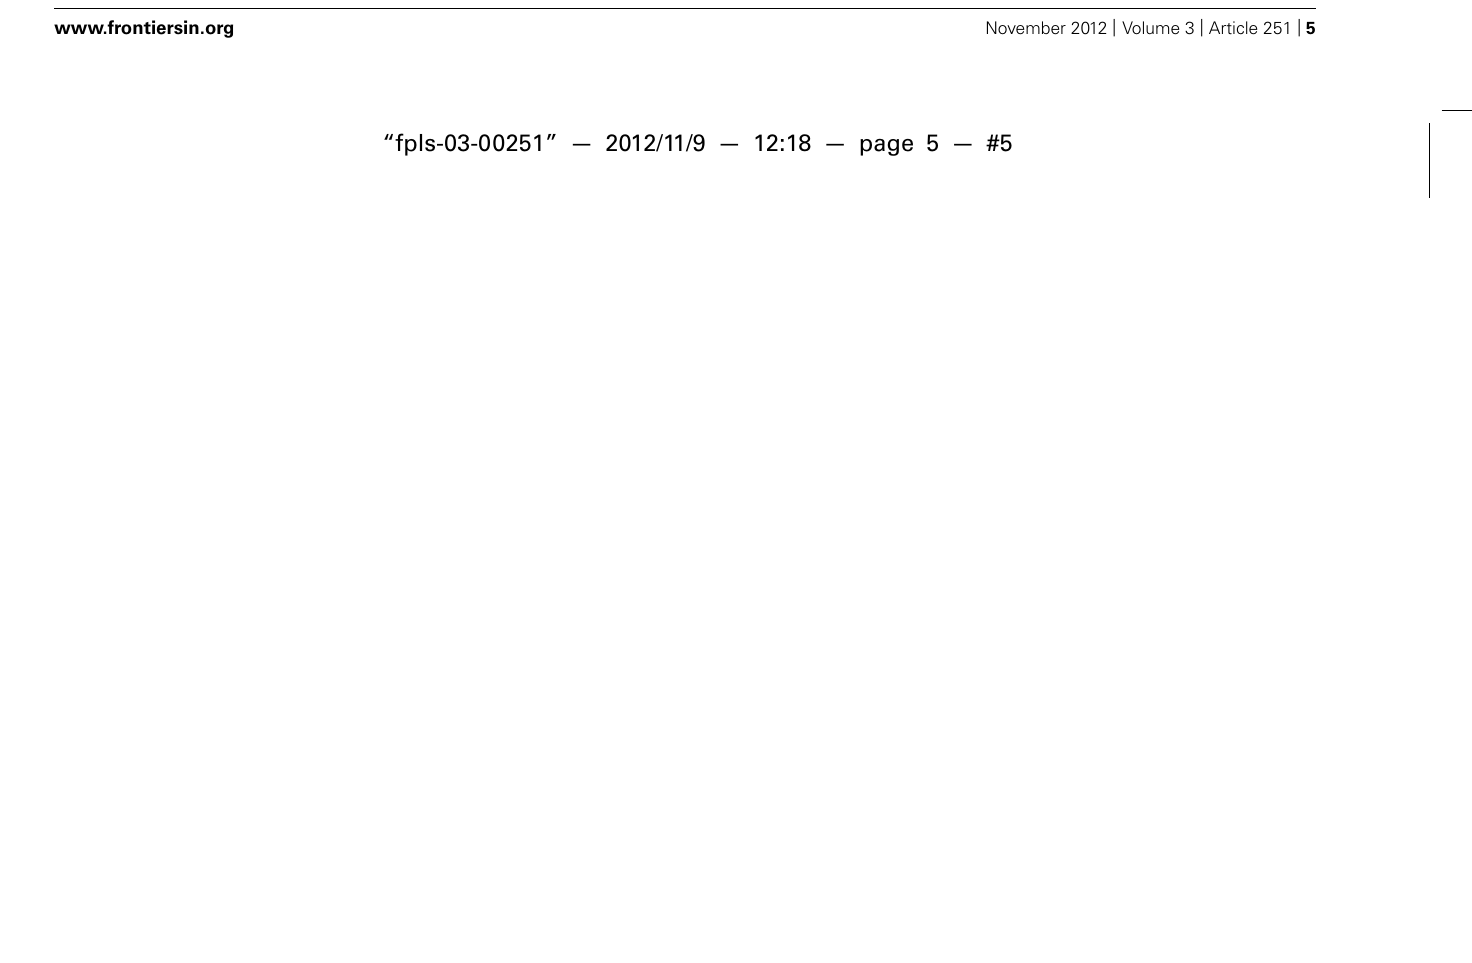
is representative for three independent experiments. Right panel: increase in root length after 15 days.The values shown are mean of six repeats ± SD (indicated by error bars). Student’s t -test revealed that Col-0 and kco3-1 are not significantly different ( P > 0.1). (D) Oxidative stress. After five days of H 2 O 2 stress, Col-0 and kco3-1 plants showed symptoms such as bleaching of leaves and plant decay.The figure is representative for two independent experiments. (E) K + deficient and K + sufficient medium. Lower panel: increase in root length after 15 days was plotted as means ± SD (indicated by error bars) of six repeats. Student’s t -test did not reveal any significant difference between Col-0 and kco3-1 ( P >